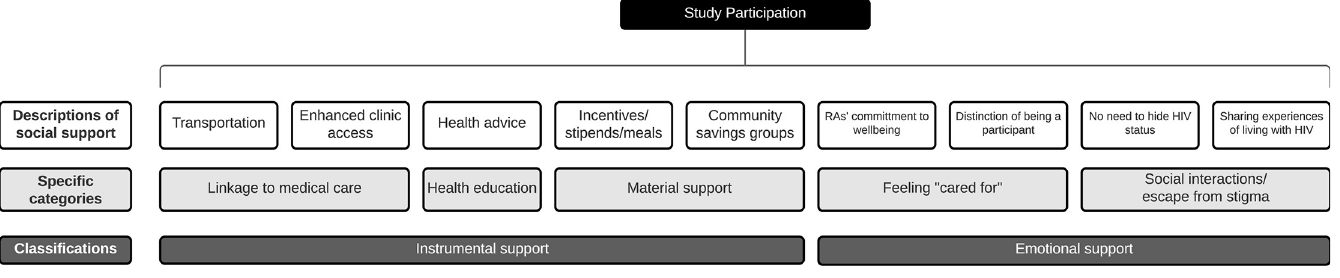
Fig 1. Categorization of social support arising from study